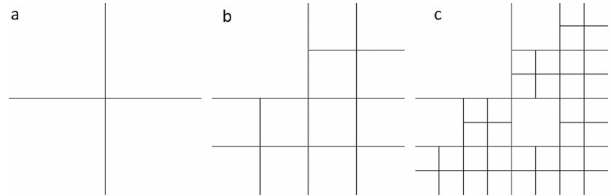
Figure 1. Generating deterministic fractal-fracture networks, initia- tor ( i = 0), generator ( i = 1), and i = 2 (modified from Roy et al., 2007).